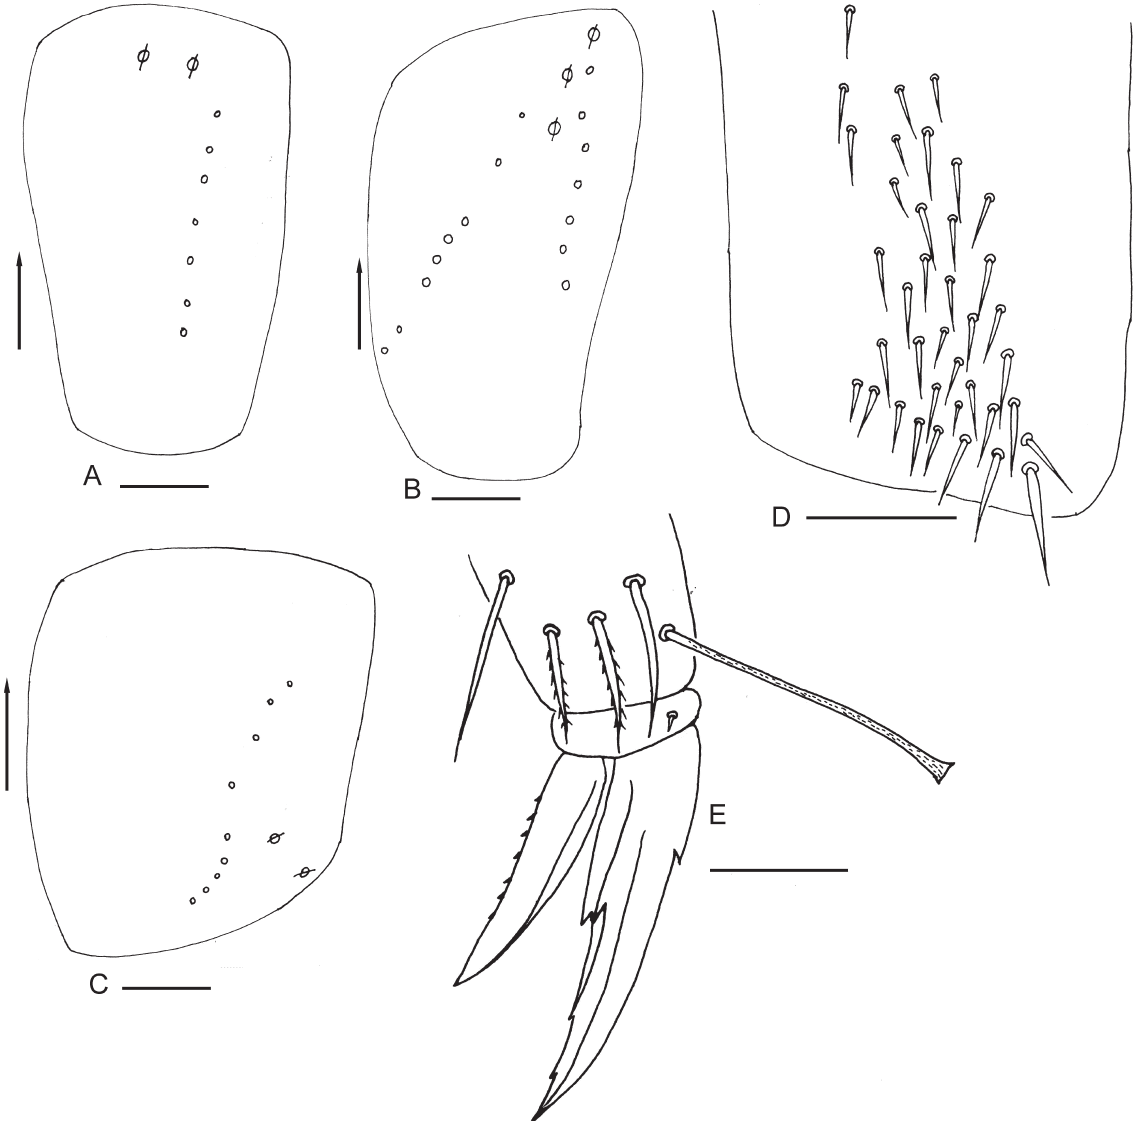
Fig. 13. Lepidocyrtus ( S. ) wanningensis sp. nov. A . Coxal macrochaetal formula of fore leg. B . Coxal macrochaetal formula of middle leg. C . Coxal macrochaetal formula of hind leg. D . Trochanteral organ. E . Hind foot complex (anterior view). Scale bars: 20